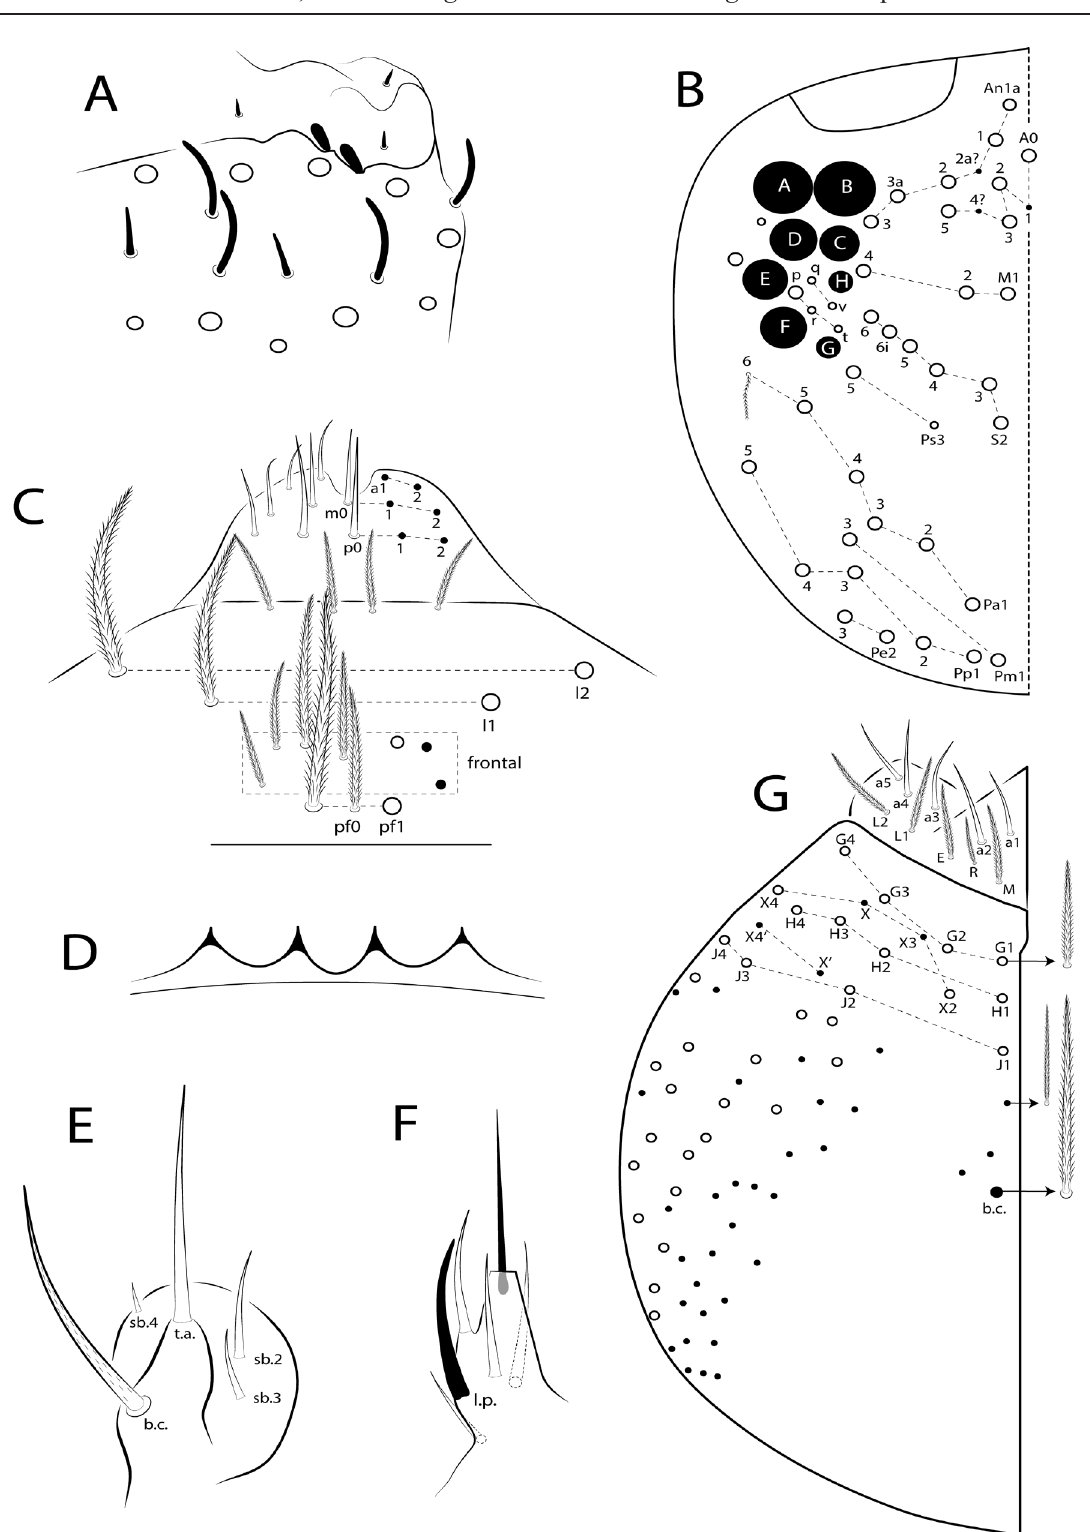
Fig. 5. Willowsia nigromaculata (Lubbock, 1873), head (left side). A . Ant III apical organ. B . Cephalic dorsal chaetotaxy. C . Chaetotaxy of clypeus, prelabrum and labrum. D . Labral papillae. E . Maxillary outer lobe. F . Papilla E of labial palp (ventral view). G . Basomedian and basolateral labial fields and complete postlabial chaetotaxy. Abbreviations: see Material and